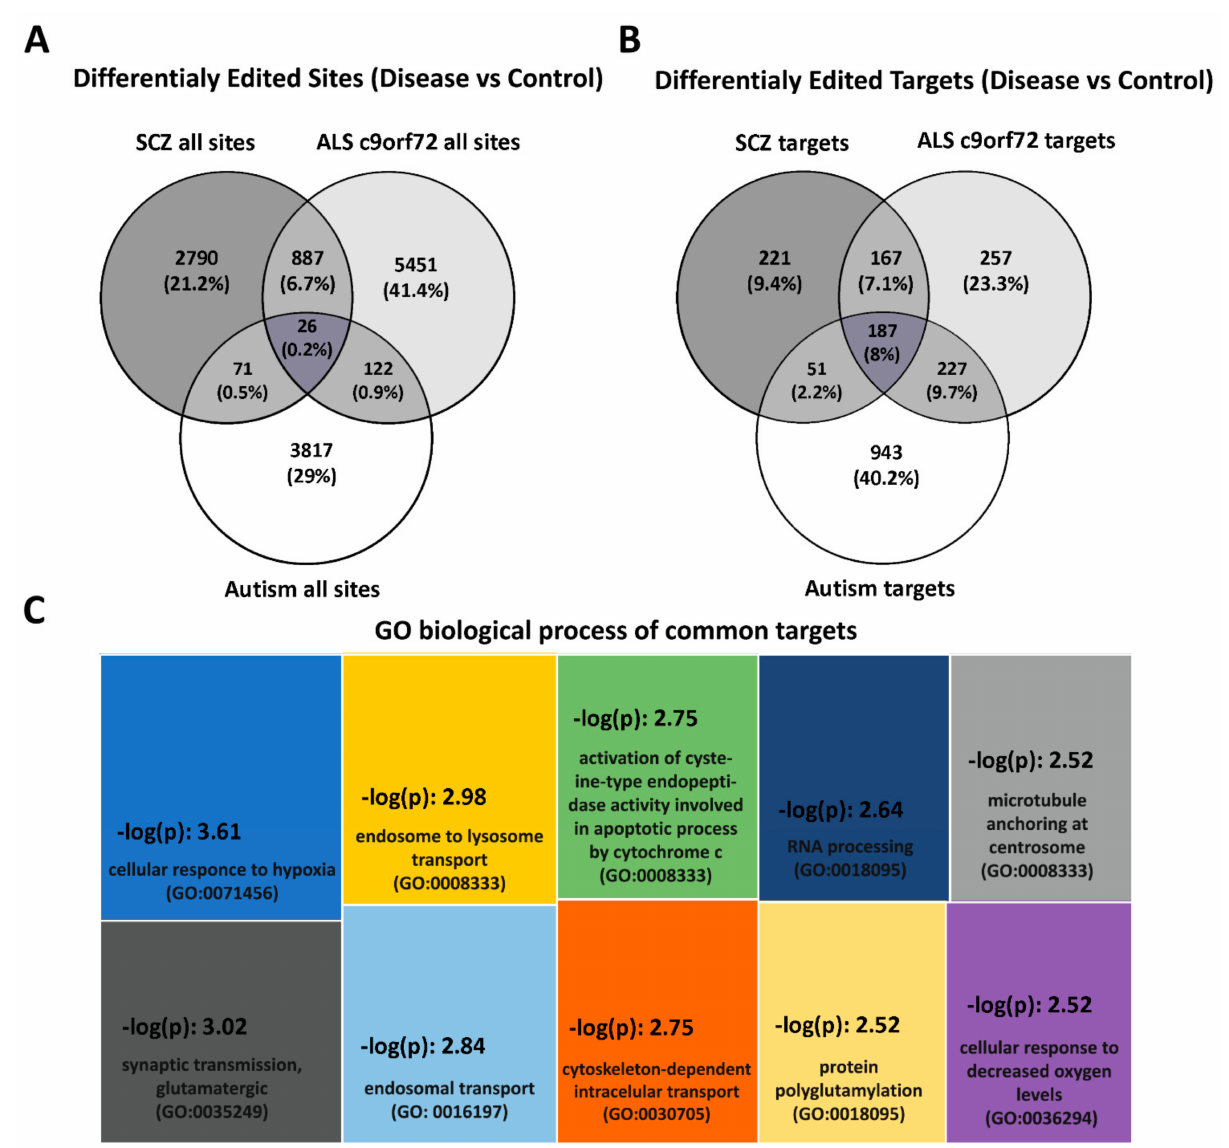
Figure 2. Differential editing patterns in different human neuropsychiatric, autoimmune/ neurodegenerative and neurological brain disorders compared to healthy individuals. ( A ) Venn diagrams depicting differentially edited sites identified in schizophrenia (SCZ), genetic ALS (ALS c9orf72) and autism. The intersections represent editing events identified as differentially edited in more than one condition. Twenty-six editing sites have been commonly identified as differentially edited in all three conditions. ( B ) Venn diagrams depict differentially edited transcripts (targets) in the same human disorders as in A. The intersections represent editing targets identified as differentially edited in more than one condition. Please note that a higher number of transcripts (187) are differentially edited in all three conditions compared to common, individual editing events (intersection in A), suggesting disease-associated editing that converges in common targets. ( C ) Gene ontology (GO) analysis of the differentially edited targets in all three human brain disorders ( n = 187). Enrichment values are given as –log ( p ) values (higher –log (p) values indicate greater statistical significance). Differentially edited transcripts are involved in molecular processes associated with hypoxia, synaptic transmission, endosome/lysosome function, cytoskeleton, apoptosis, protein and RNA processing, all of which have been reported as deregulated in these disorders. Differential editing data ( p < 0.05) reported in the studies of [35,45,51] were utilized for the analysis. Reported data correspond to different brain